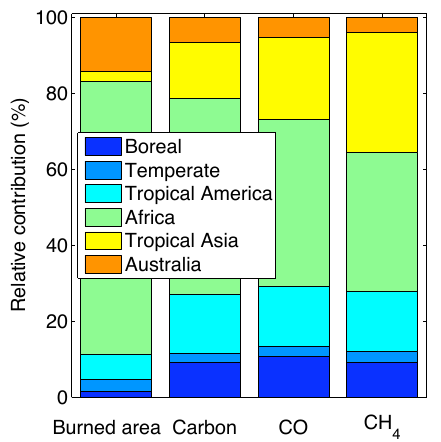
Fig. 10. Relative contribution (%) from different regions to 1997-2009 average global total burned area and fire emissions of carbon, CO, and CH 4 . The different regions were composed of BONA and BOAS (Boreal), TENA, EURO, CEAS (Temperate), CEAM, NHSA, and SHSA (Tropical America), MIDE, NHAF, and SHAF (Africa), SEAS and EQAS (Tropical Asia), and AUST for Australia.